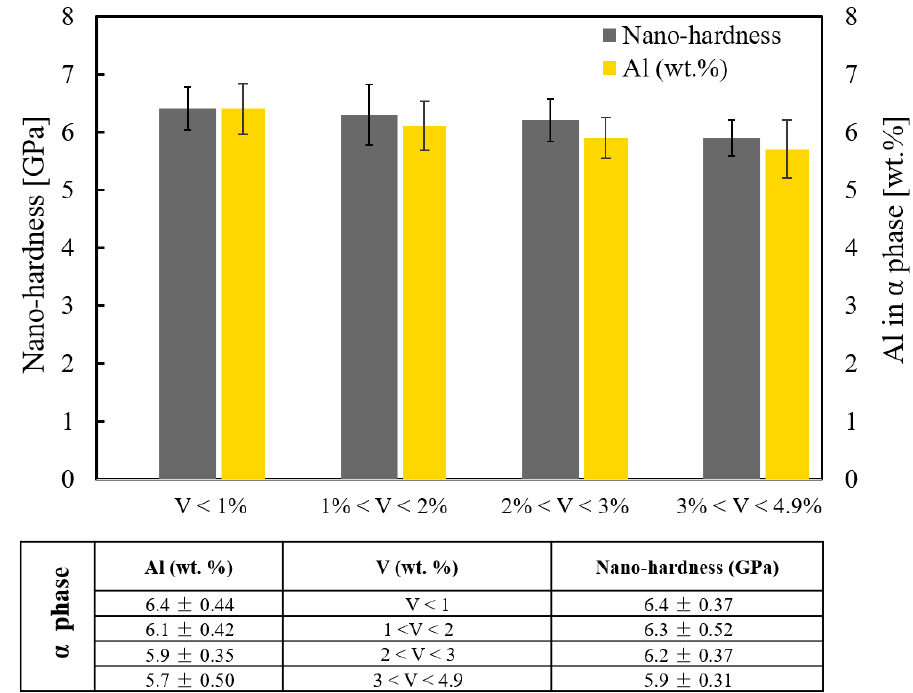
Figure 12. Nano-hardness values of the α phase with different contents of vanadium and